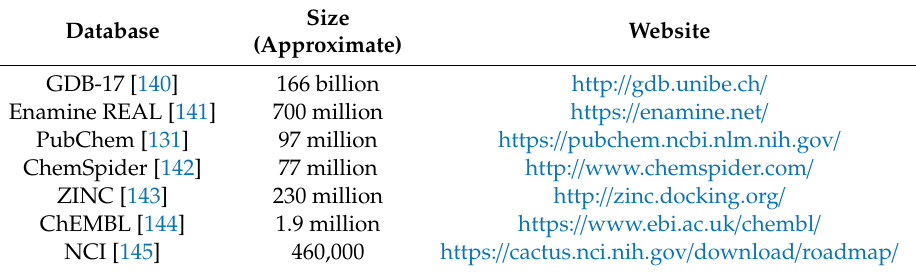
Table 2. Publicly available compound